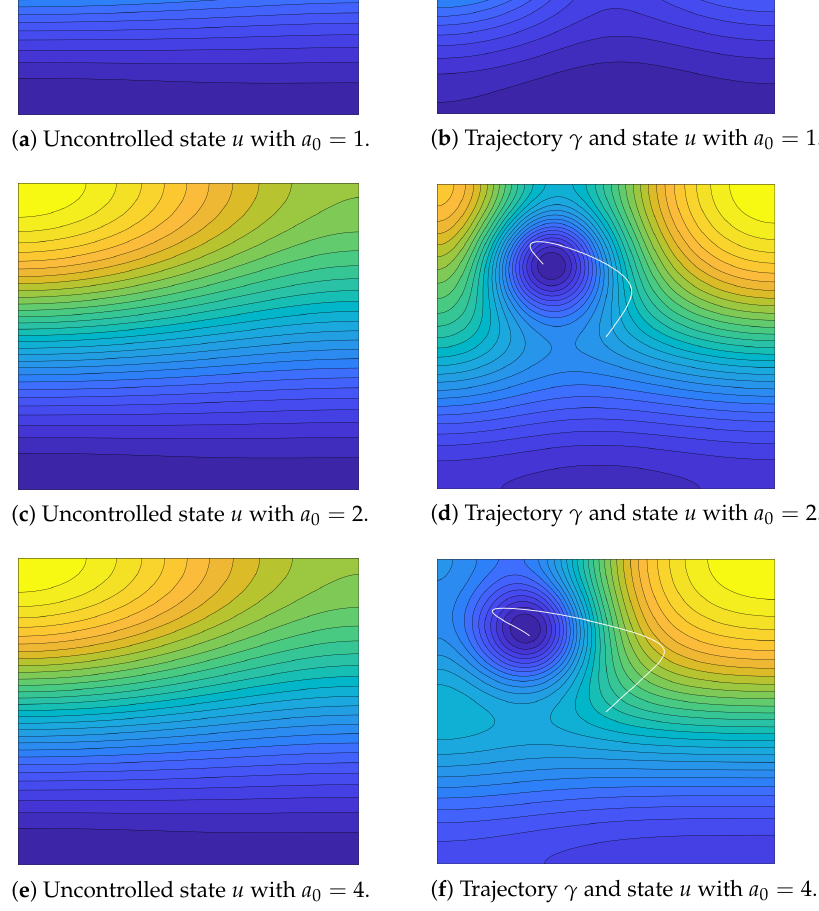
Figure 8. Uncontrolled state u ( a , c , e ) and Trajectory γ and controlled state u ( b , d , f ) at T = 2 for a ( x , t ) in (41) with a 0 = 1,2,4 with minimum and maximal values given in Table